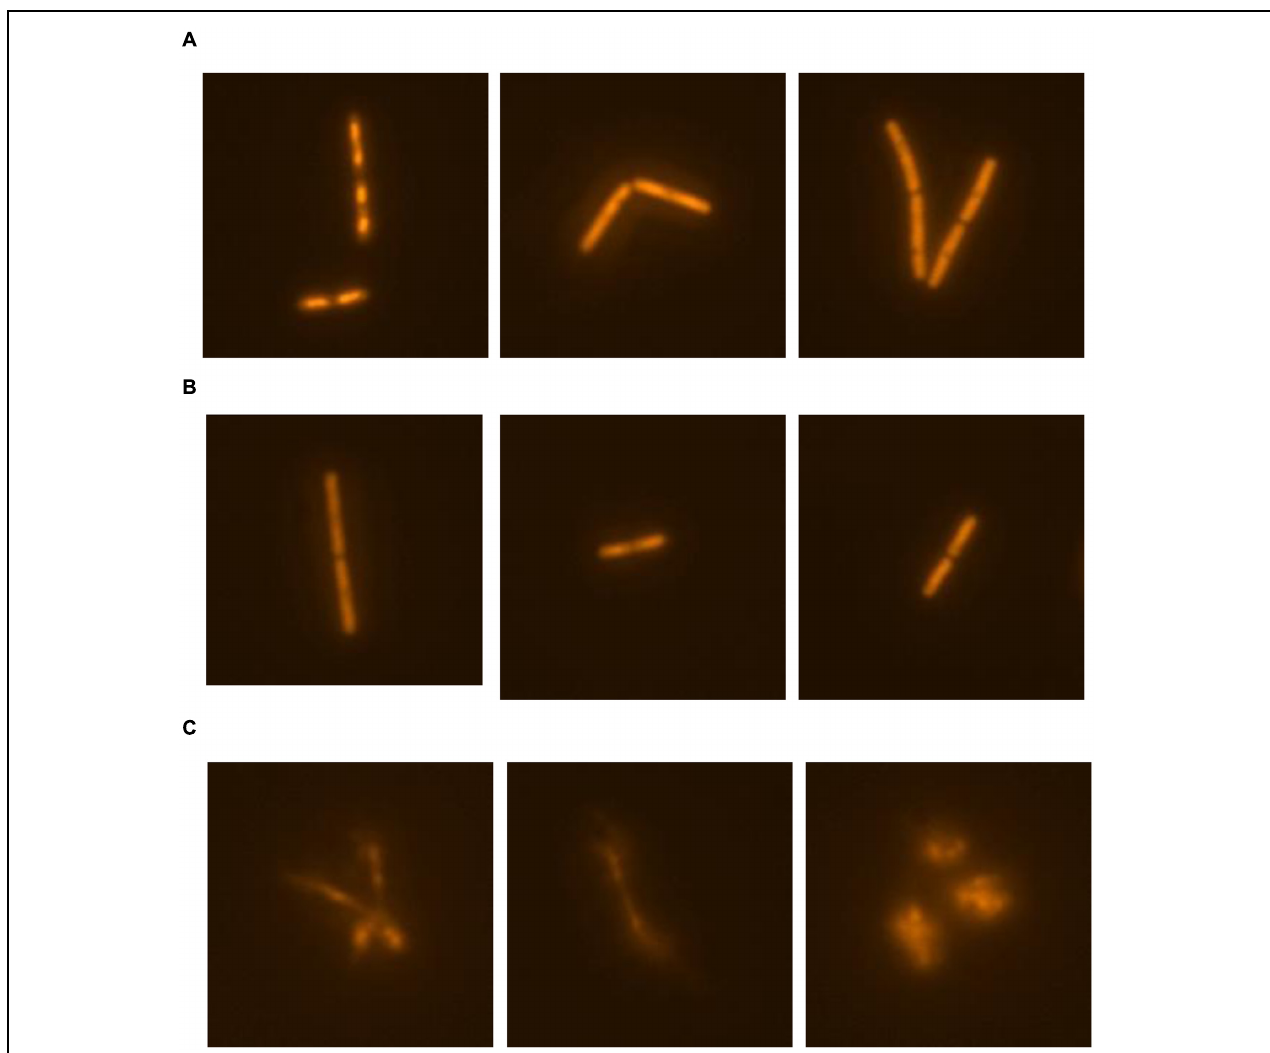
FIGURE 5 | The modified comet assay for studying prodigiosin mediated cell lysis of B. subtilis PS-216 wt cells grown in LB medium at 37 ◦ C and 200 rpm. (A) non-treated bacterial cells; (B) control cells treated with 0.19% (V/V) of ethanol; (C) cells treated with 5.9 mg L − 1 of prodigiosin. Cells were treated in the middle exponential phase and were inspected 1 h after the treatment. The gels were stained with GelRedTM. The images were observed with epifluorescent